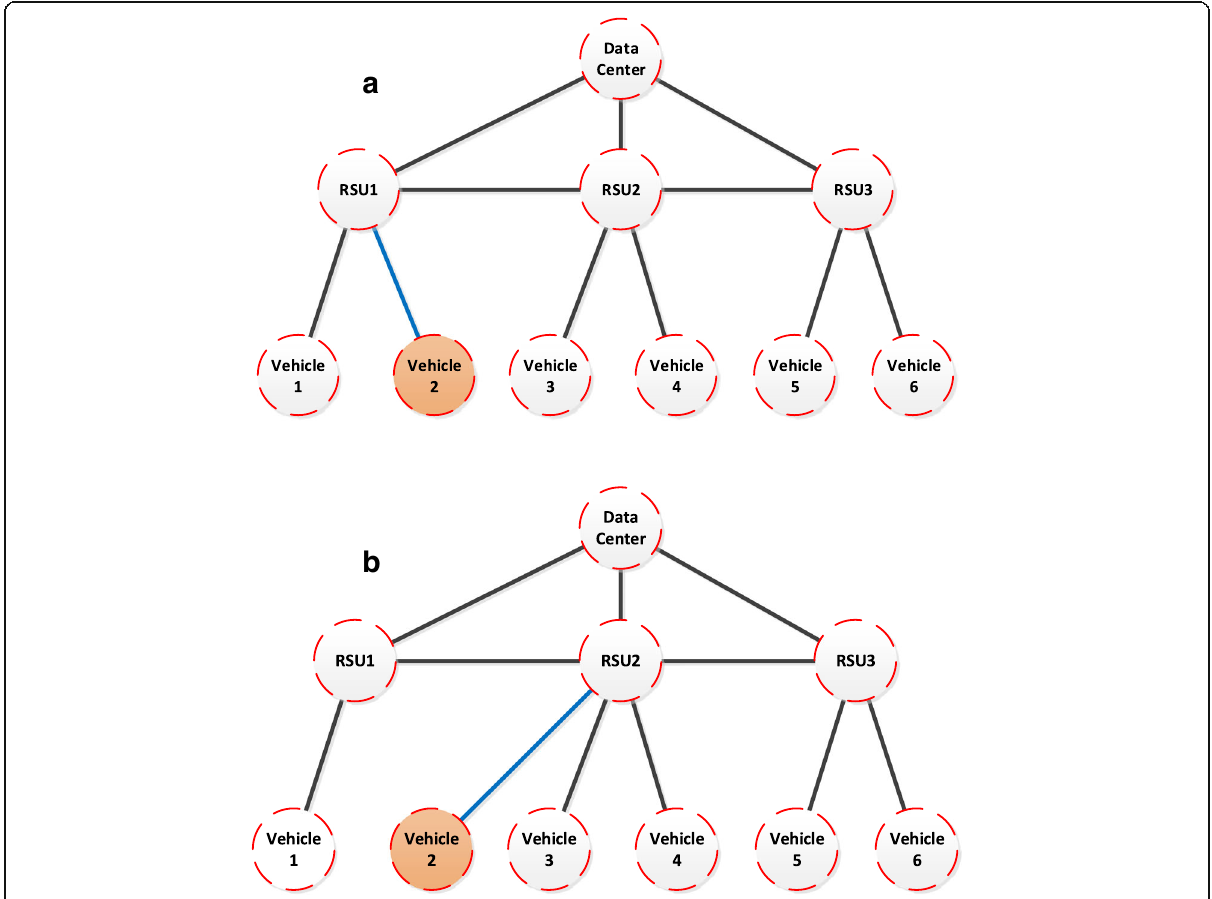
Fig. 2 Topology of simulations: a topology before communication link interrupt and b topology after communication link